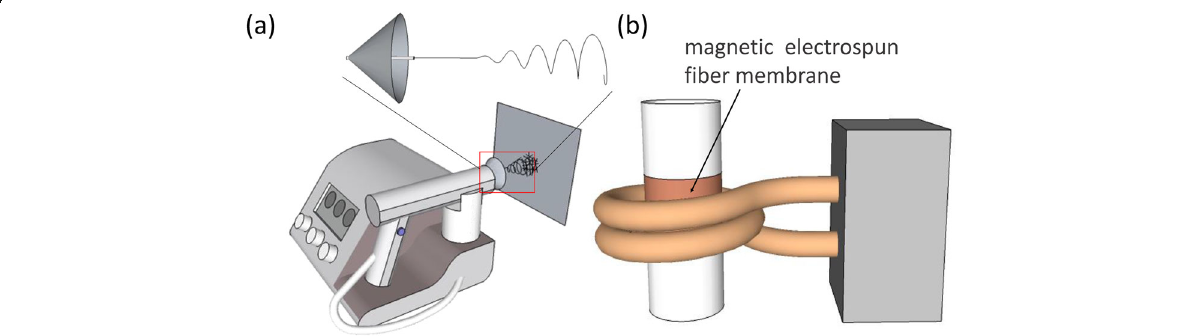
Fig. 1 a Schematic diagram of portable electrostatic spinning device and auxiliary electrode. b Schematic representation of the field generator, coils, and data acquisition system for recording